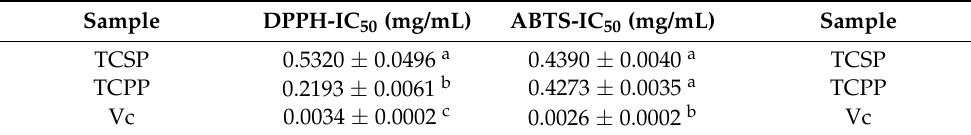
Table 3. IC 50 of TCSP and TCPP (mean ± standard